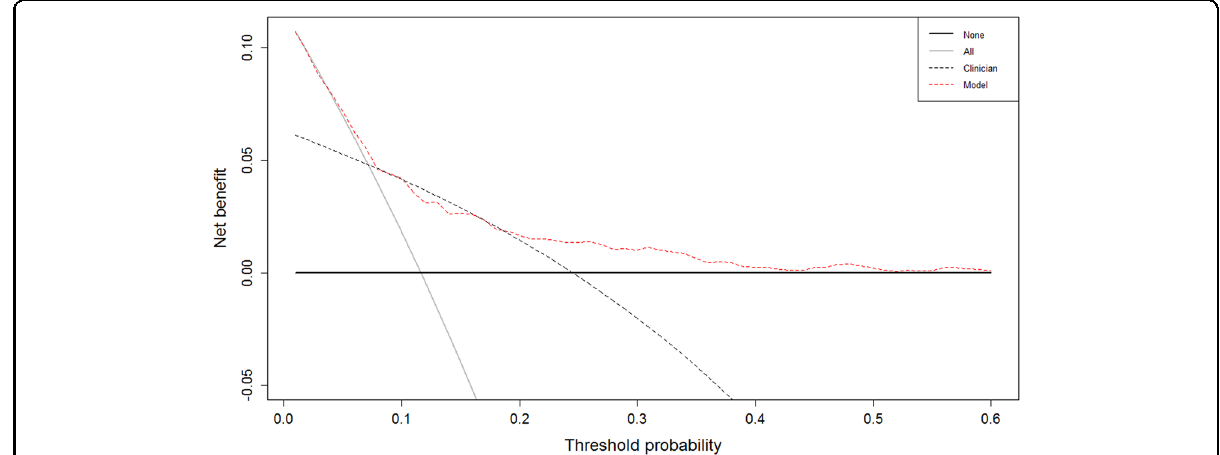
Fig. 3 Decision curve analysis. Black horizontal line represents treating none, the grey diagonal line represents treating all, the black dotted line represents the actual discharge destination (i.e. transfer to secondary care), the red dotted line represents the prediction